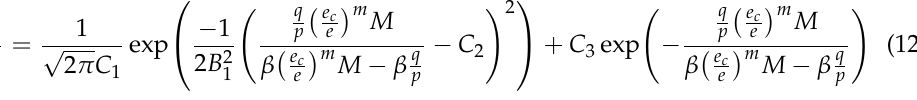
plane, as shown in Equation